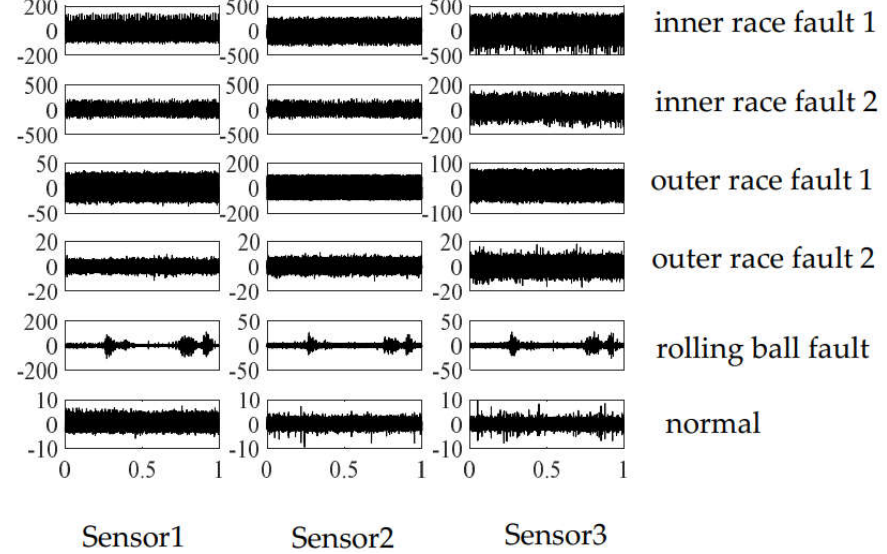
Figure 5. Time-domain vibration signals of rolling bearing from three different sensors.